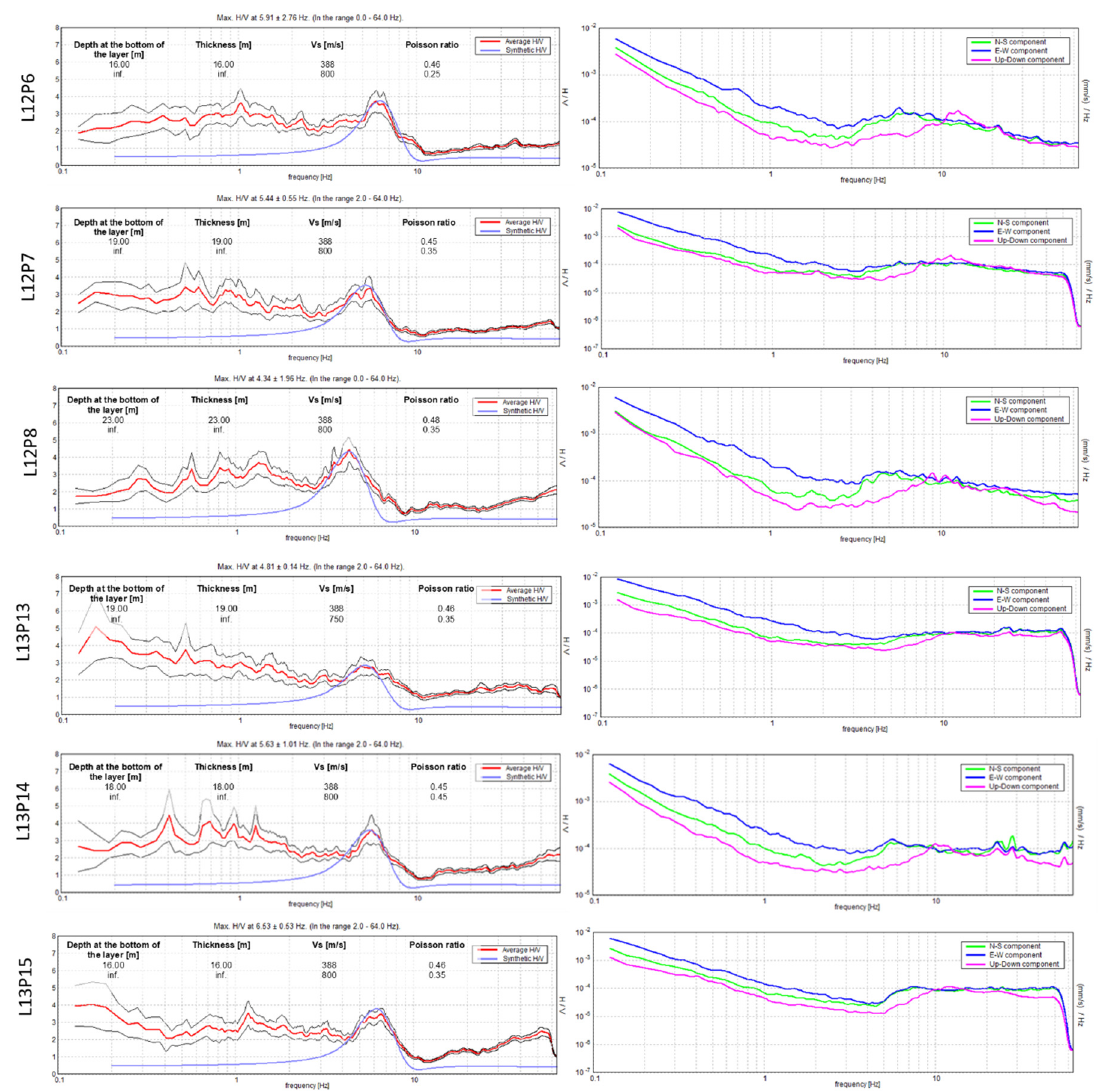
Figure 10. Single station H/V observed and modelled at the six nearest stations to the beach MASW location. From top to bottom, the labels LIPJ indicate points 6, 7, and 8 on line 12 and points 13, 14, and 15 on line 13. The right panels show the single component spectra as solid blue, green, and magenta lines. The left panels show the averaged H/V as a solid red line, with the standard deviation as thinner black lines. The modelled or synthetic spectra are shown as a blue line and the main model parameters are shown as text. Table 3. Estimated elevation of wave-cut platform from beach elevation and modelled beach thick- ness at the six nearest points to the beach MASW survey.